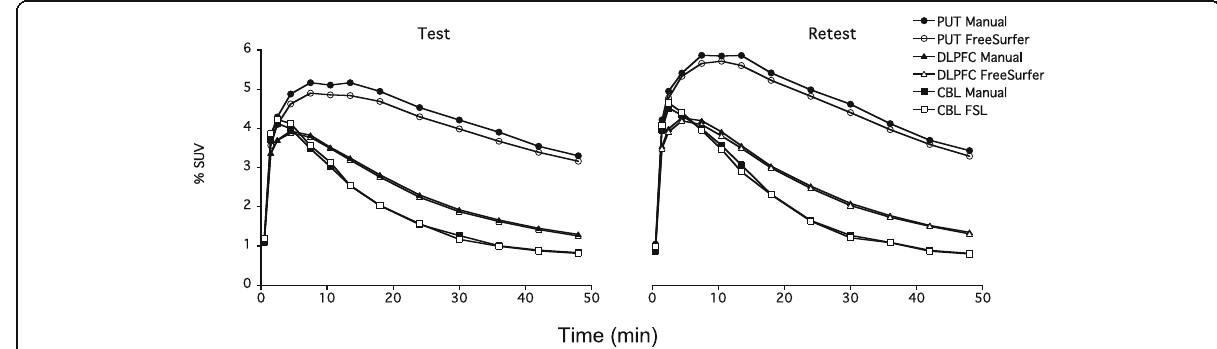
Fig 3 Time-activity curves from a healthy volunteer after i.v. injection of [ 11 C]SCH23390 in the morning (left) and afternoon (right). The curves were derived from realigned dynamic PET images using manually and automatically generated ROIs, respectively. PUT = putamen, DLPFC = dorsolateral prefrontal cortex, CBL = cerebellum. SUV = standardized uptake value = (C ROI /inj dose) × body